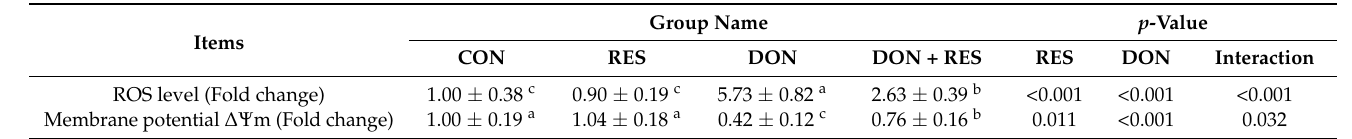
Table 8. The effect of RES on mitochondrial ROS production and mitochondrial membrane potential in the piglet